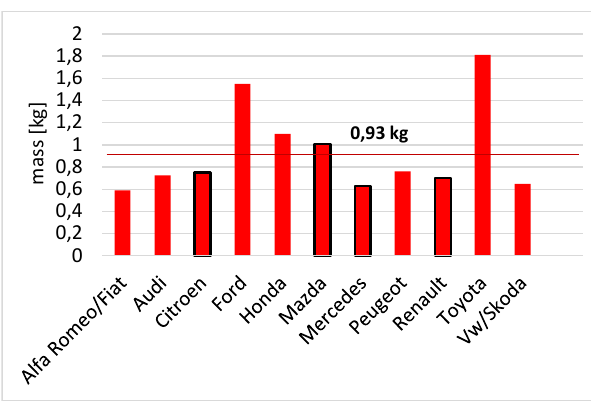
Fig. 5. Weight of each